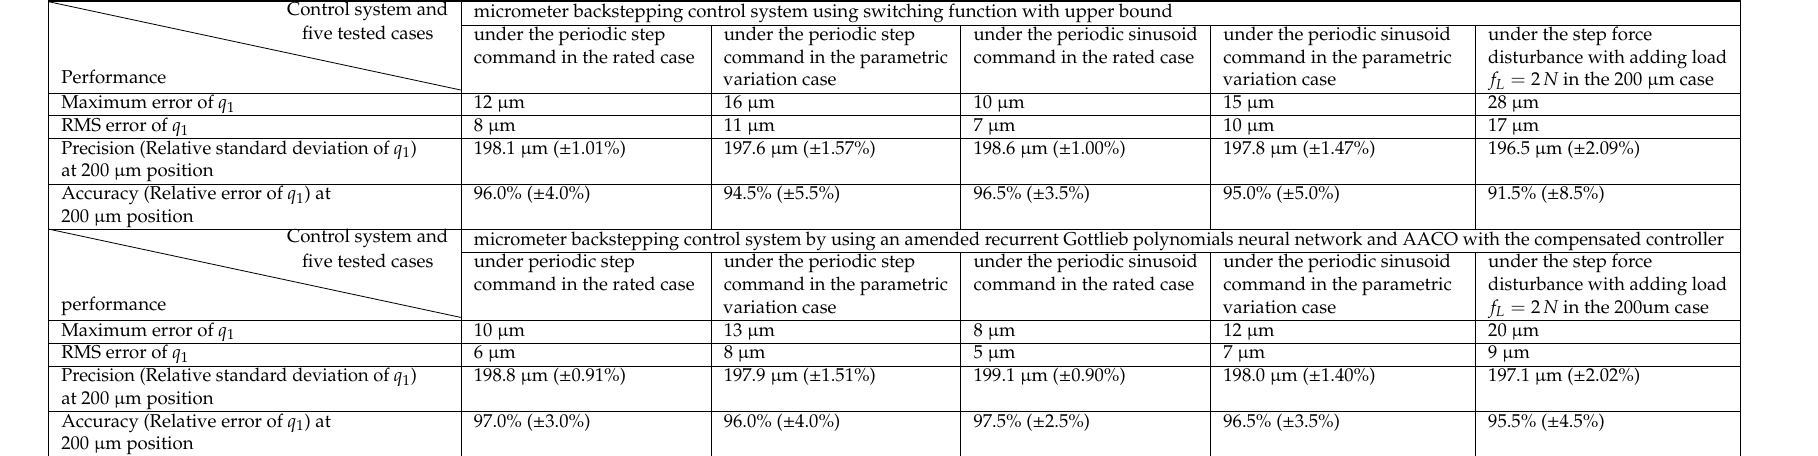
Table 1. Performance comparison of control